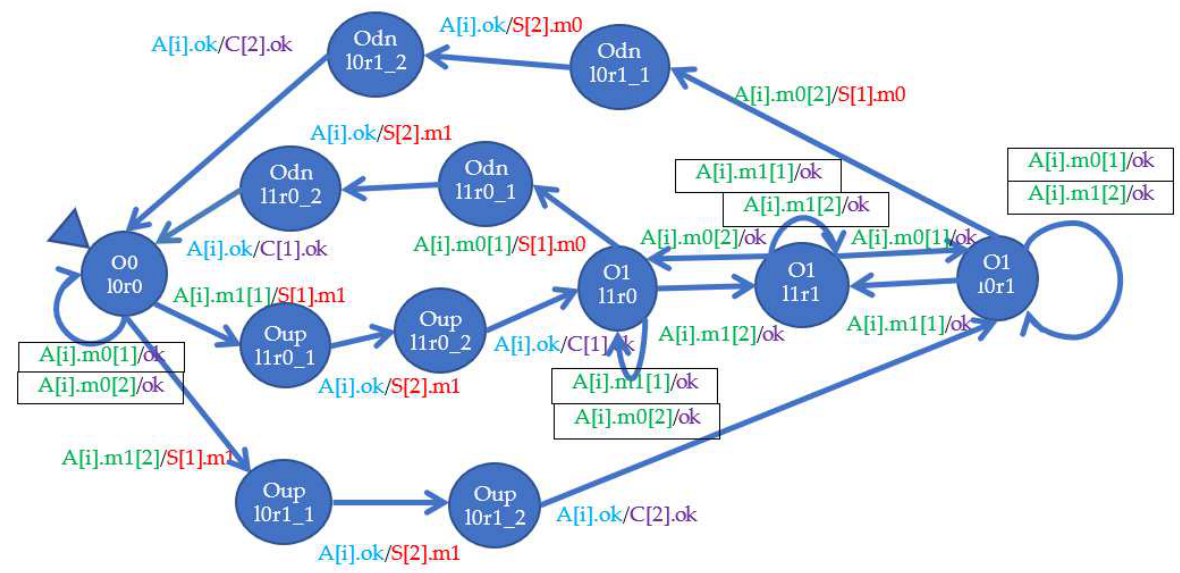
Figure 8. Galvanic connection model.